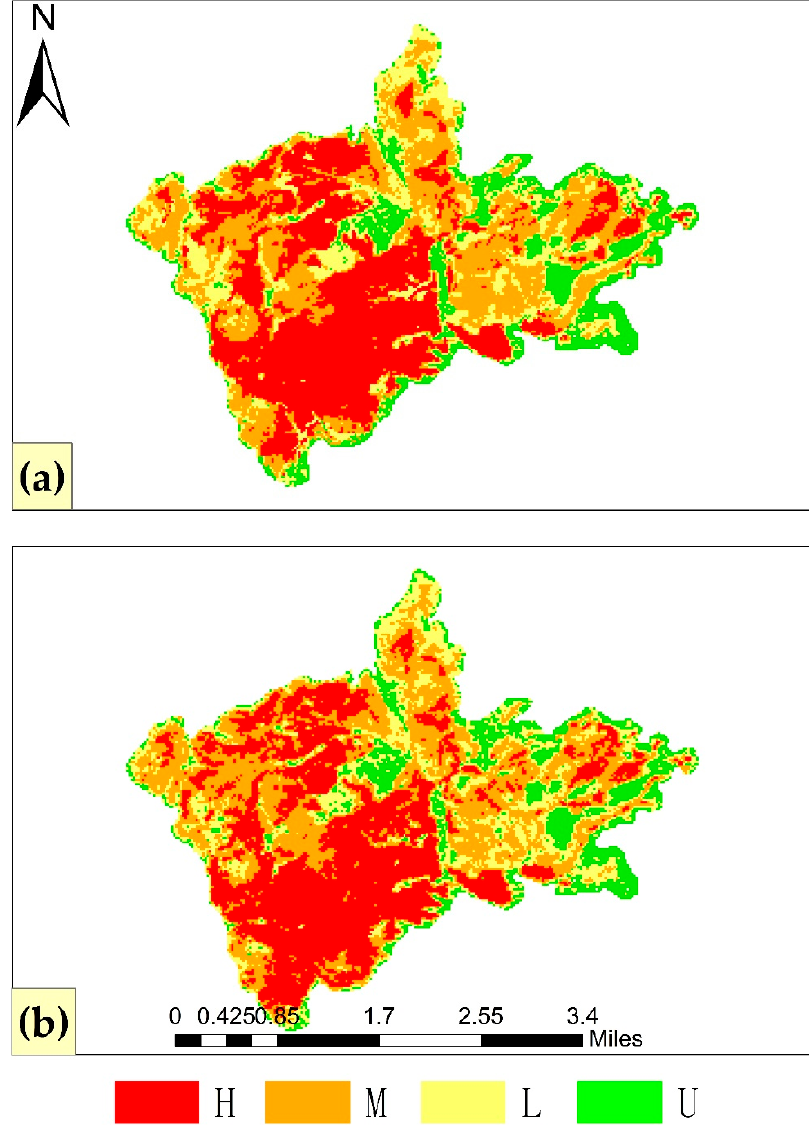
Figure 10. Comparison of BO fire severity mapping results of ( a ) BAP method; ( b ) SI method.